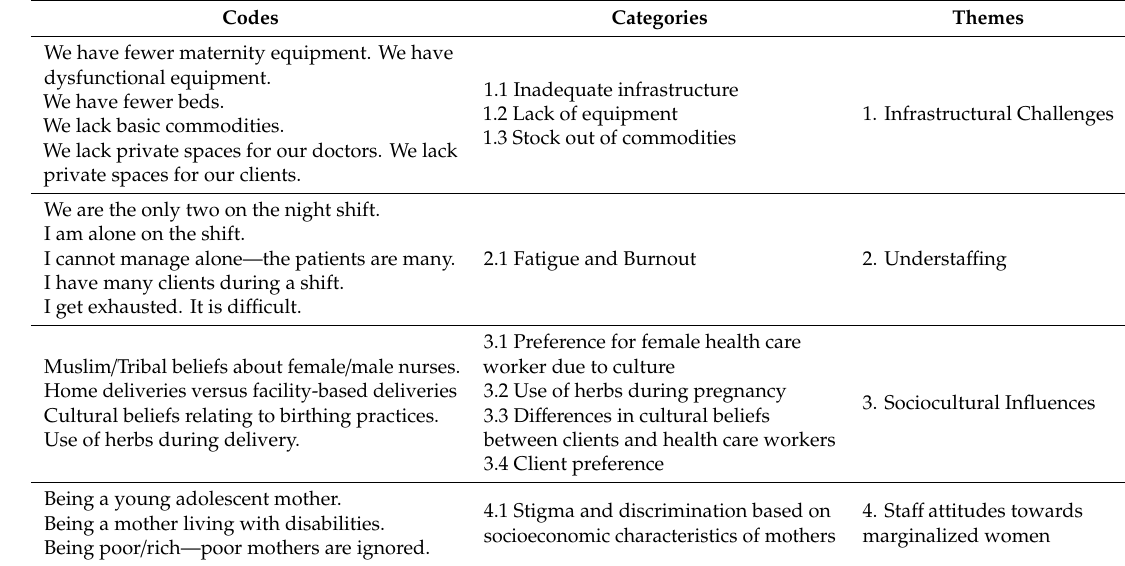
Table 1. Codes, categories, and themes of health care workers’ experiences with disrespectful maternity